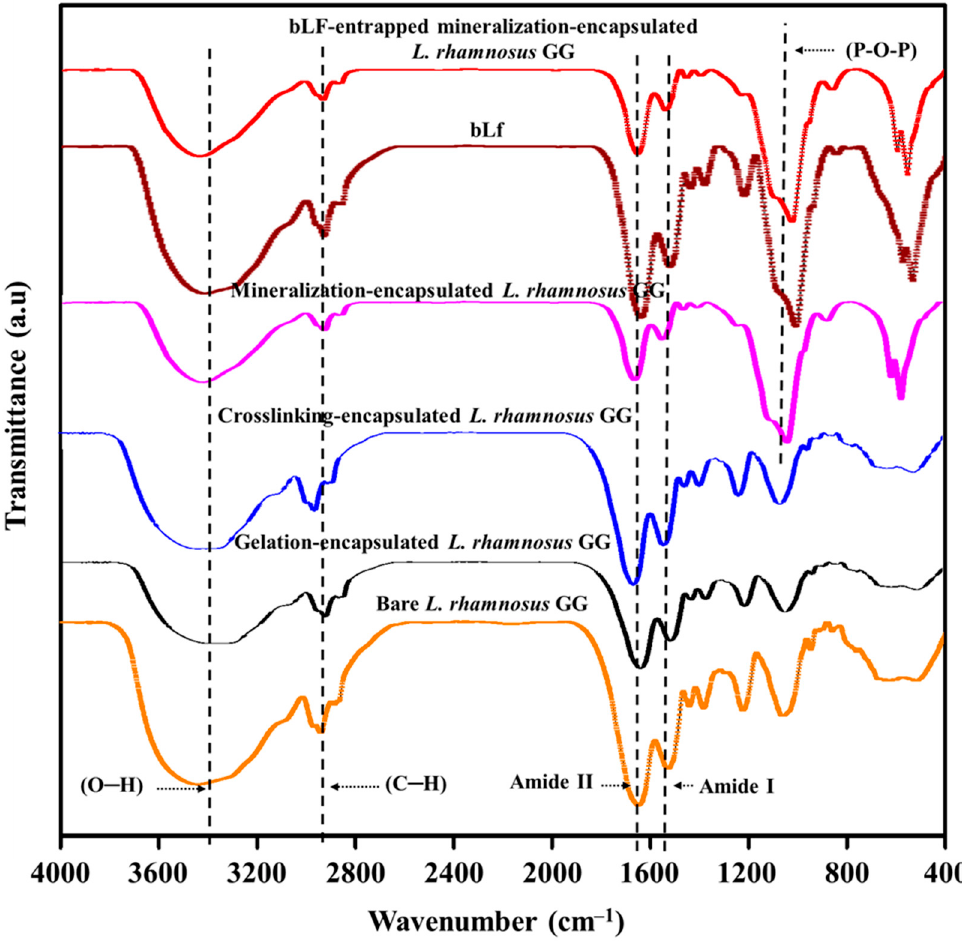
Figure 6. FTIR spectroscopic analysis of the interactions between the surface of L. rhamnosus GG cells, modifying materials, and drugs: Chemical structural analyses of bare L. rhamnosus GG cells, gelation-encapsulated L. rhamnosus GG cells, crosslinking-encapsulated L. rhamnosus GG cells, mineralization-encapsulated L. rhamnosus GG cells, bLf, and bLf-entrapped mineralization-encapsulated L. rhamnosus GG cells.